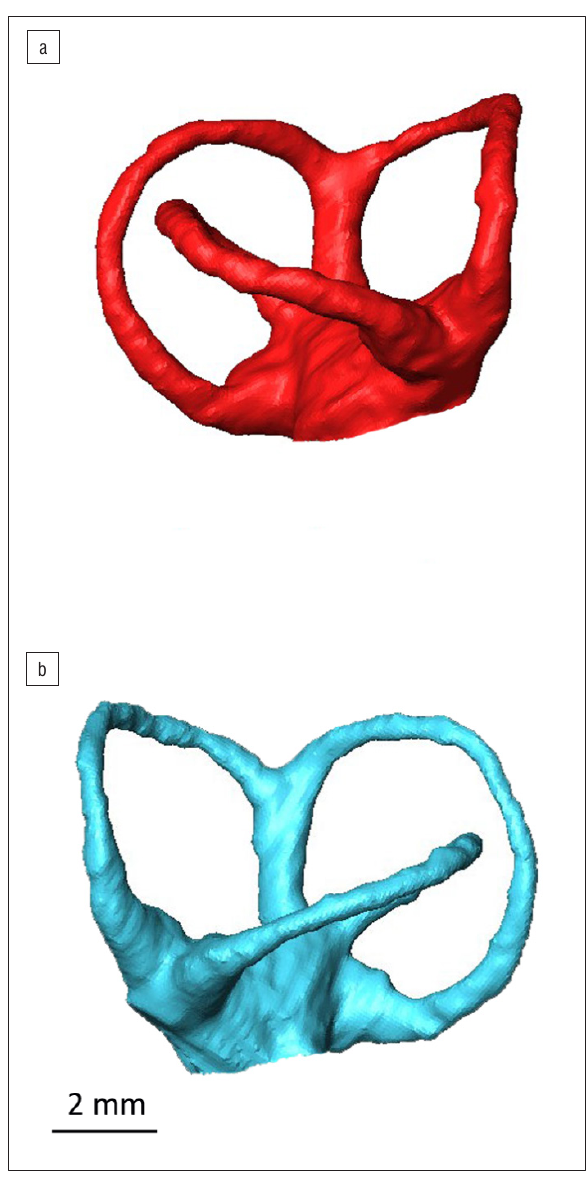
Figure 1: Virtual rendering of the semicircular canals of (a) Sts 565 and (b) Sts 564. Note differences in size but very close similarity in shape, despite the fact that the specimens have been attributed to Parapapio jonesi and P. broomi . Morphometric analyses indicate a high probability of